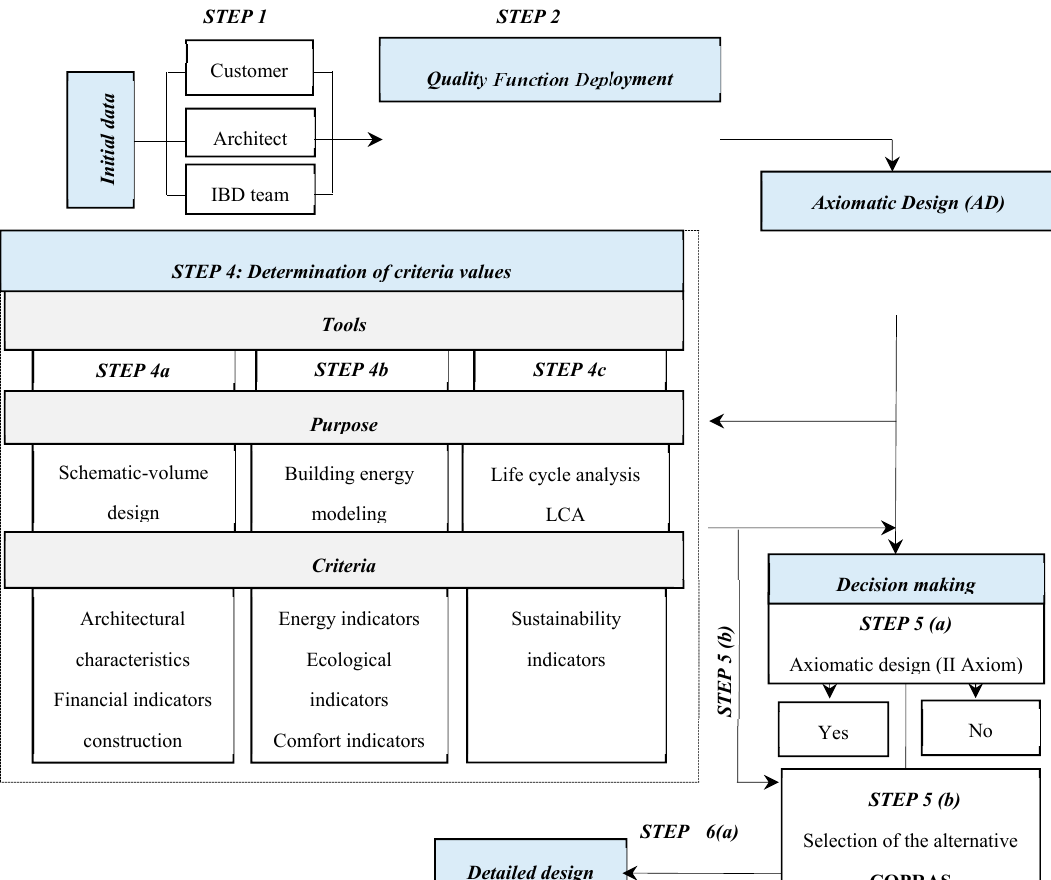
Figure 1. The technology of the architectural design